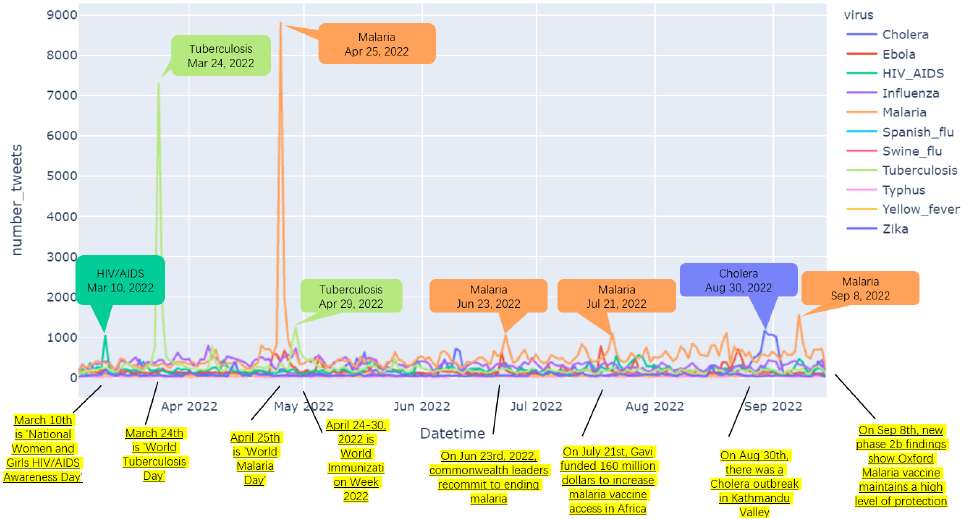
Figure 6. The number of tweets over time for the various epidemics.